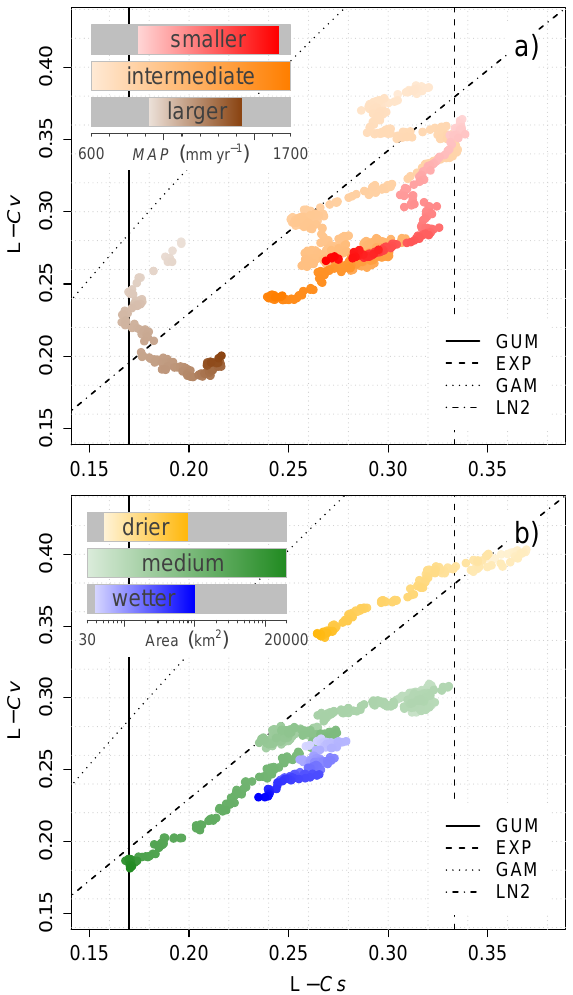
Figure 4. L-moment ratio diagrams for the subsets defined by (a) catchment area (smaller, intermediate, larger), and (b) MAP (wetter, medium, drier) described in Fig. 3. Each point represents the record length WMA over 70 catchments of L-Cv against corresponding values of L-Cs and the colour intensity is proportional to (a) MAP and (b) catchment